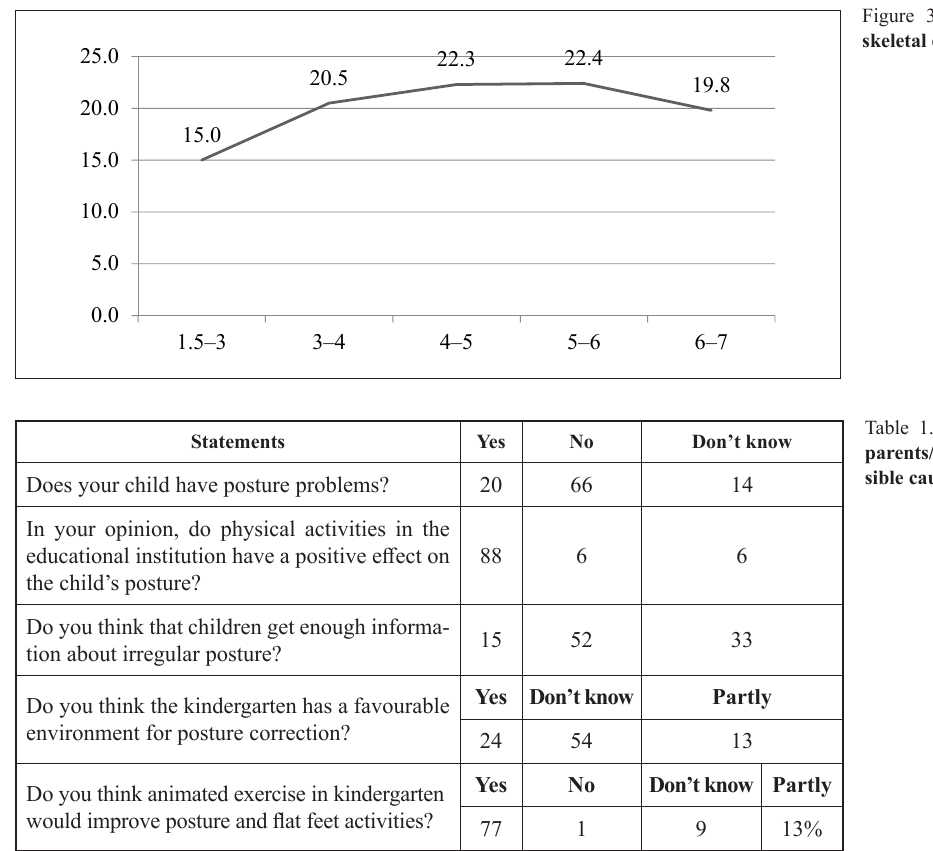
Figure 2. Distribution of body weight index for children with body mass index (%)